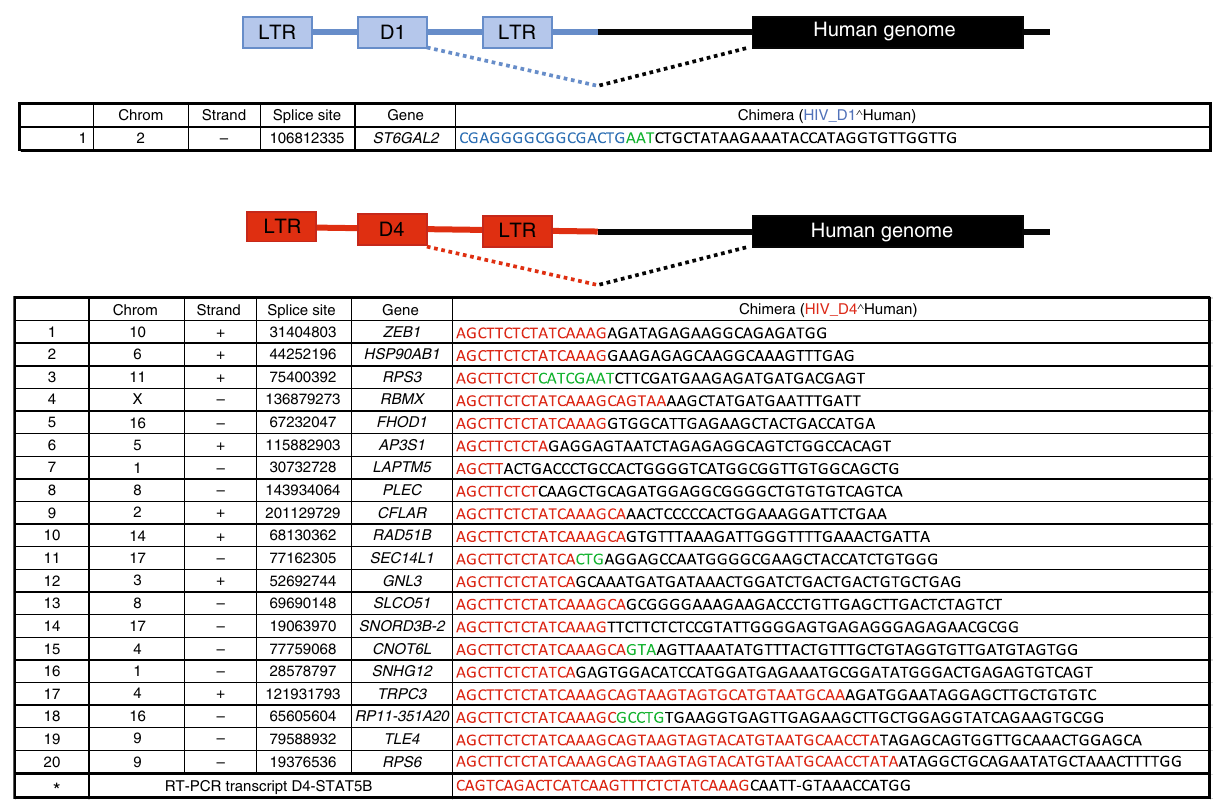
Fig. 6 HIV expression leads to chimeric transcripts between D1 or D4 and human genes. RNA-seq was performed using in vitro-infected resting cells harvested at day 7 after infection. The sequences of the chimeric transcripts between HIV D1 (blue) and human genes (black) are shown in the top panel, while those between HIV D4 (red) and human genes (black) are shown in the bottom panel. We marked in green the sequences we could not map to either HIV or the human genome.The sequence marked with an asterisk was retrieved by RT-PCR and Sanger sequencing of in vitro-infected CD4 T cells NATURE COMMUNICATIONS| (2019) 10:728